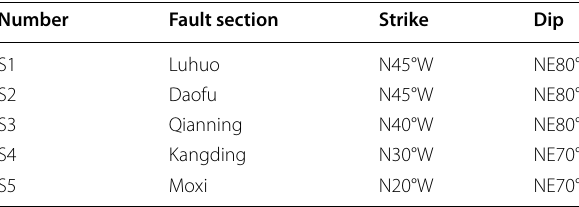
Table 1 Segmentation and geometric parameters of the Xianshuihe Fault Zone